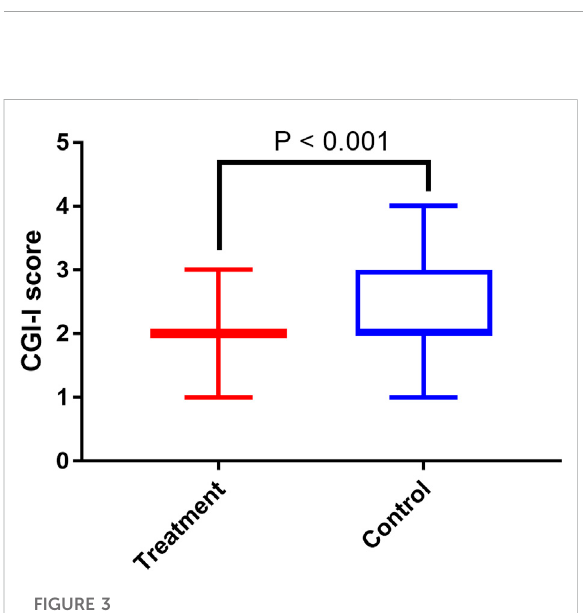
FIGURE 3 The comparison of CGI-I scores in treatment and control groups. CGI-I, clinical global impression of improvement.